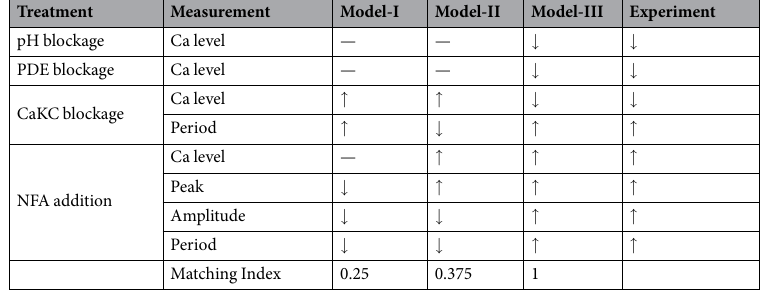
Table 2. Comparative model-experiment study of the three network models. First column indicates the pharmacological treatment under consideration; column 2 specifies the quantity being measured; column 3 are Model-I results; column 4 Model-II results; column 5, Model-III results; column 6, experimental determinations. ↑ correspond to an increase in the calcium property indicated in the measurement column. ↓ is associated with a decrease and “ − ” stands for minor changes. The matching index is defined as the ratio between the number of model/experiment coincidences and the total number of experimental determinations. A matching index of 1 indicates full agreement between experiment and specified model